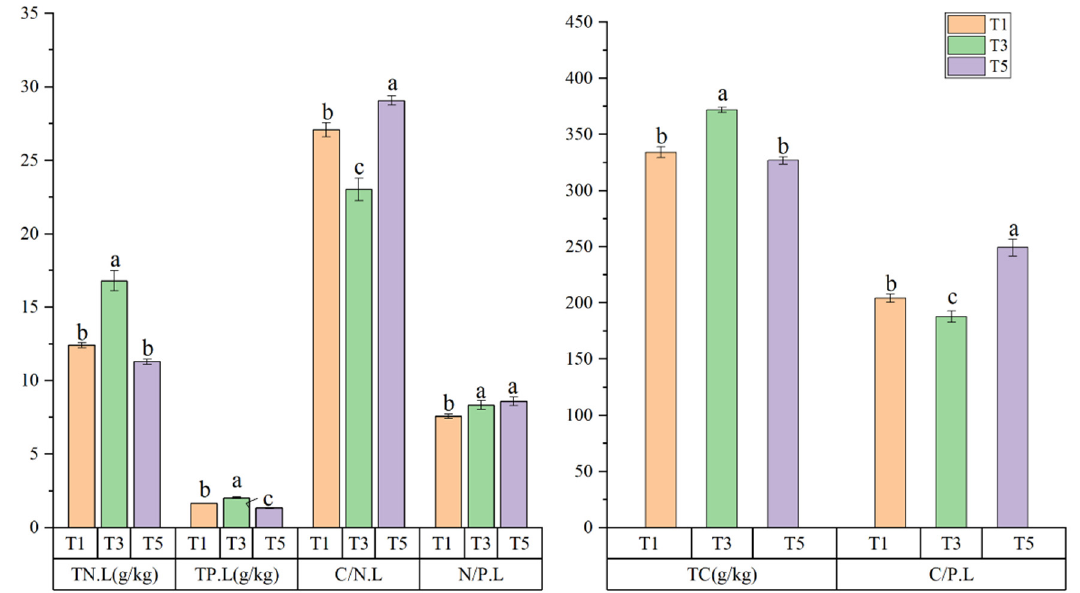
Figure 2. Carbon (C), nitrogen (N), and phosphorus (P) levels and their ratios in Spartina alterniflora leaves at different tidal levels: 1, 3, and 5 km from the coastline (T1, T3, and T5, respectively). Lowercase letters represent differences at p < 0.05. TC.L: soil total C content; TN.L: leaf total N content; TP.L: leaf total P content; C/N.L: leaf C/N ratio; C/P.L: leaf C/P ratio; N/P.L: leaf N/P ratio.